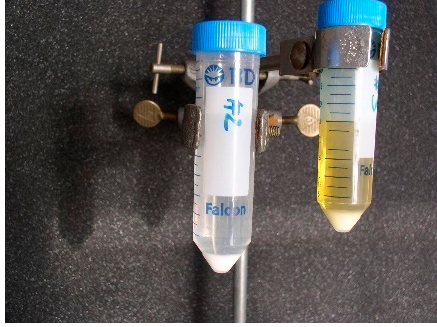
Figure 4. Dissolving ceramics in an acid medium HNO 3 +HF.